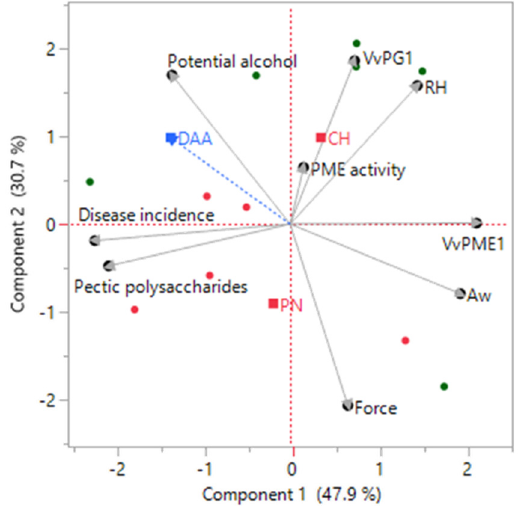
Figure 13. Principal component analysis of Chardonnay ( • ) and Pinot noir ( • ) varieties for different ripening stages according to the first and second components.